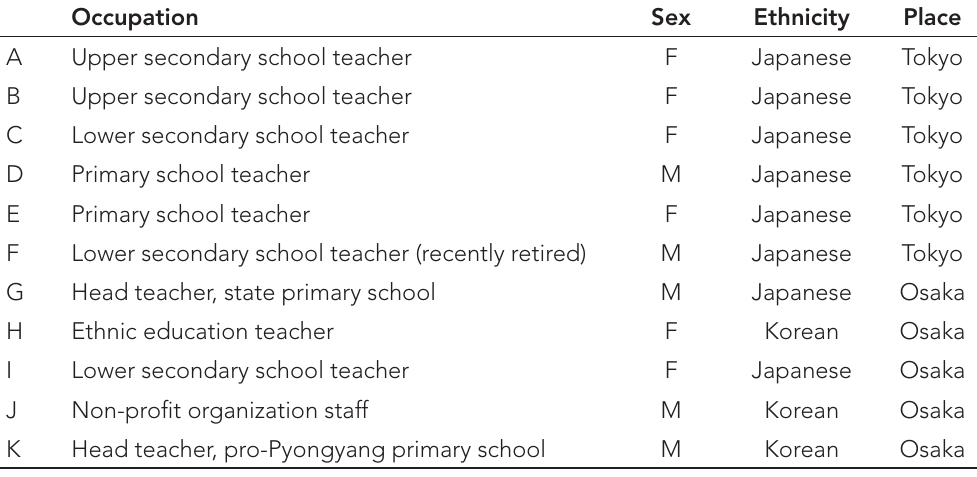
Table 1: Characteristics of interviewees